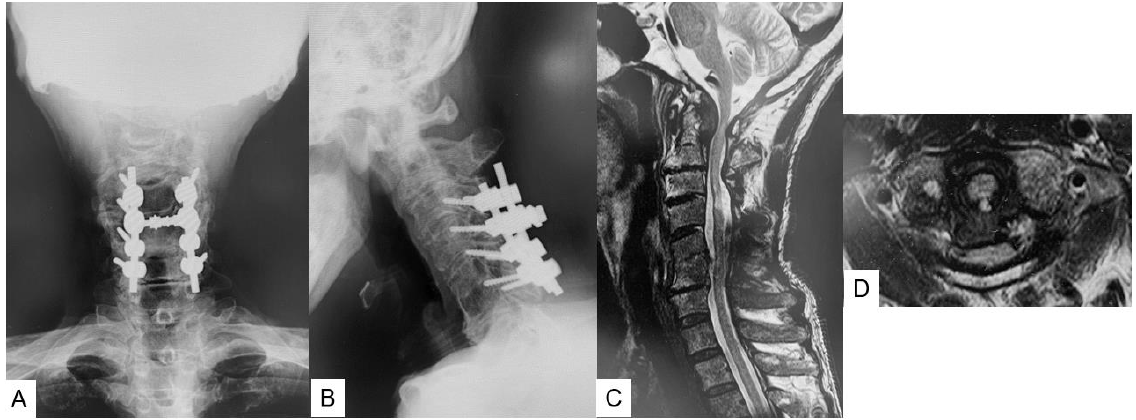
Figure 1. Preoperative images, ( A ): antero-posterior radiogram, ( B ): lateral flexion radiogram, ADI = 7 mm, ( C ): mid-sagittal T2-weighted MRI, ( D ): axial T2-weighted MRI at C1 – 2.